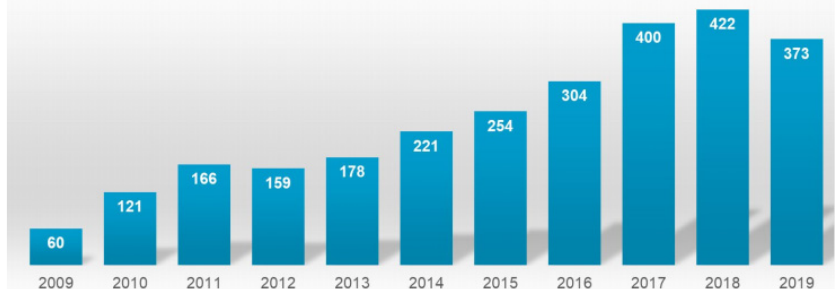
Figure 1. Numbers (×1000) of industrial robots installed per year [3]. Figure 1. Numbers ( × 1000) of industrial robots installed per year [3].